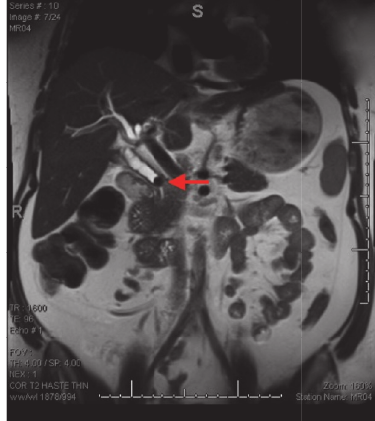
Figure 4: ERCP revealing proximal cystic duct dilatation and extravasation of contrast suggestive of a contained bile leak in this patient with a history of cholecystectomy. The contained bile leak is marked with an arrow.